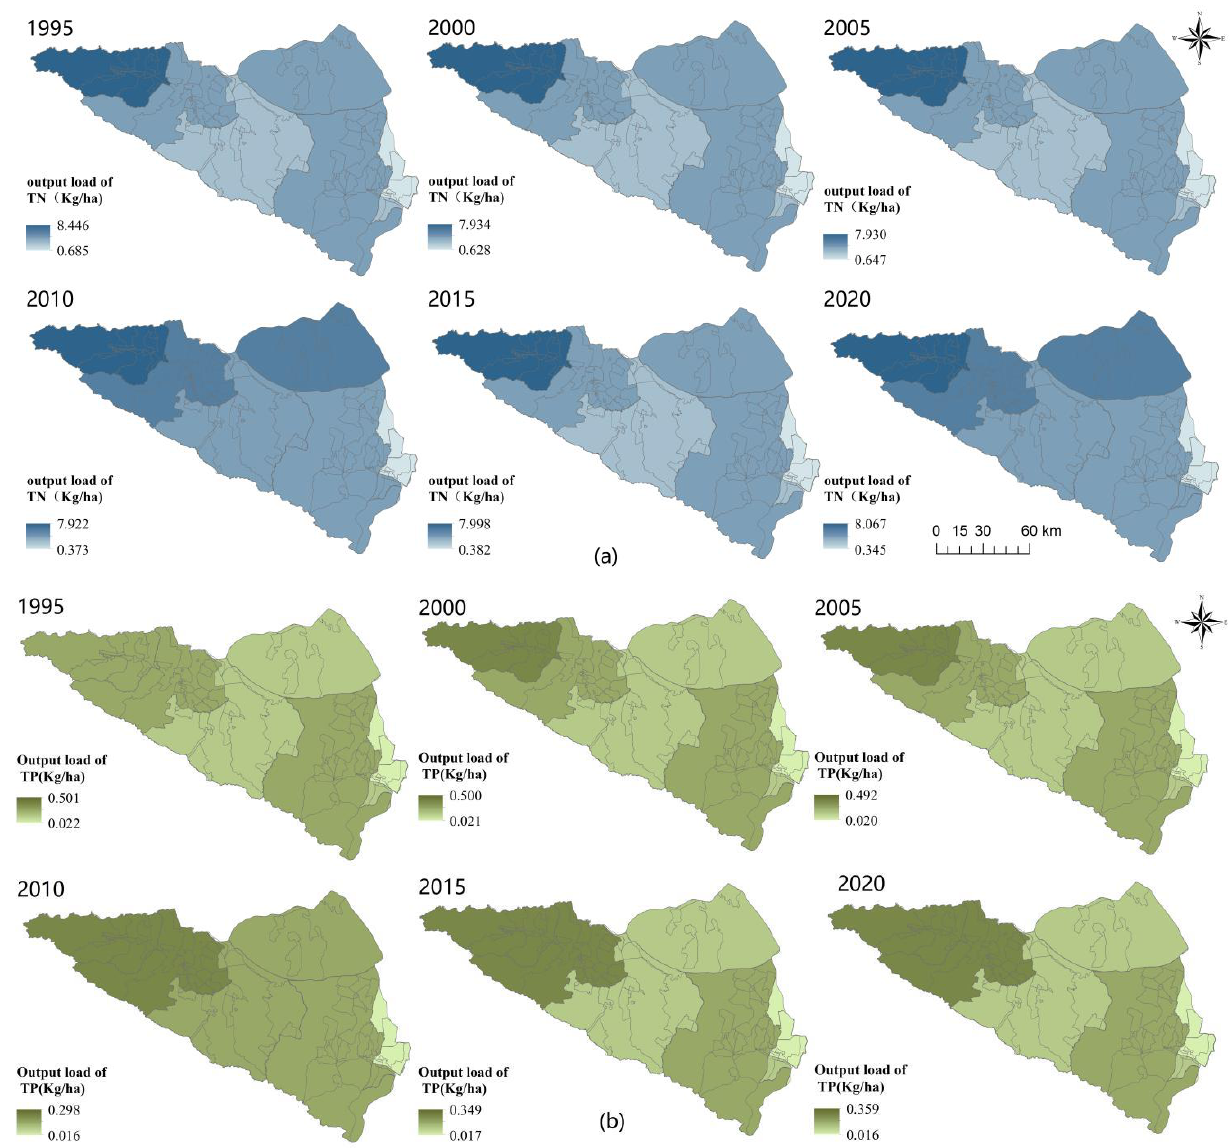
Figure 9. Nitrogen export loads ( a ) and phosphorus export loads ( b ) from the Ebinur Lake Basin